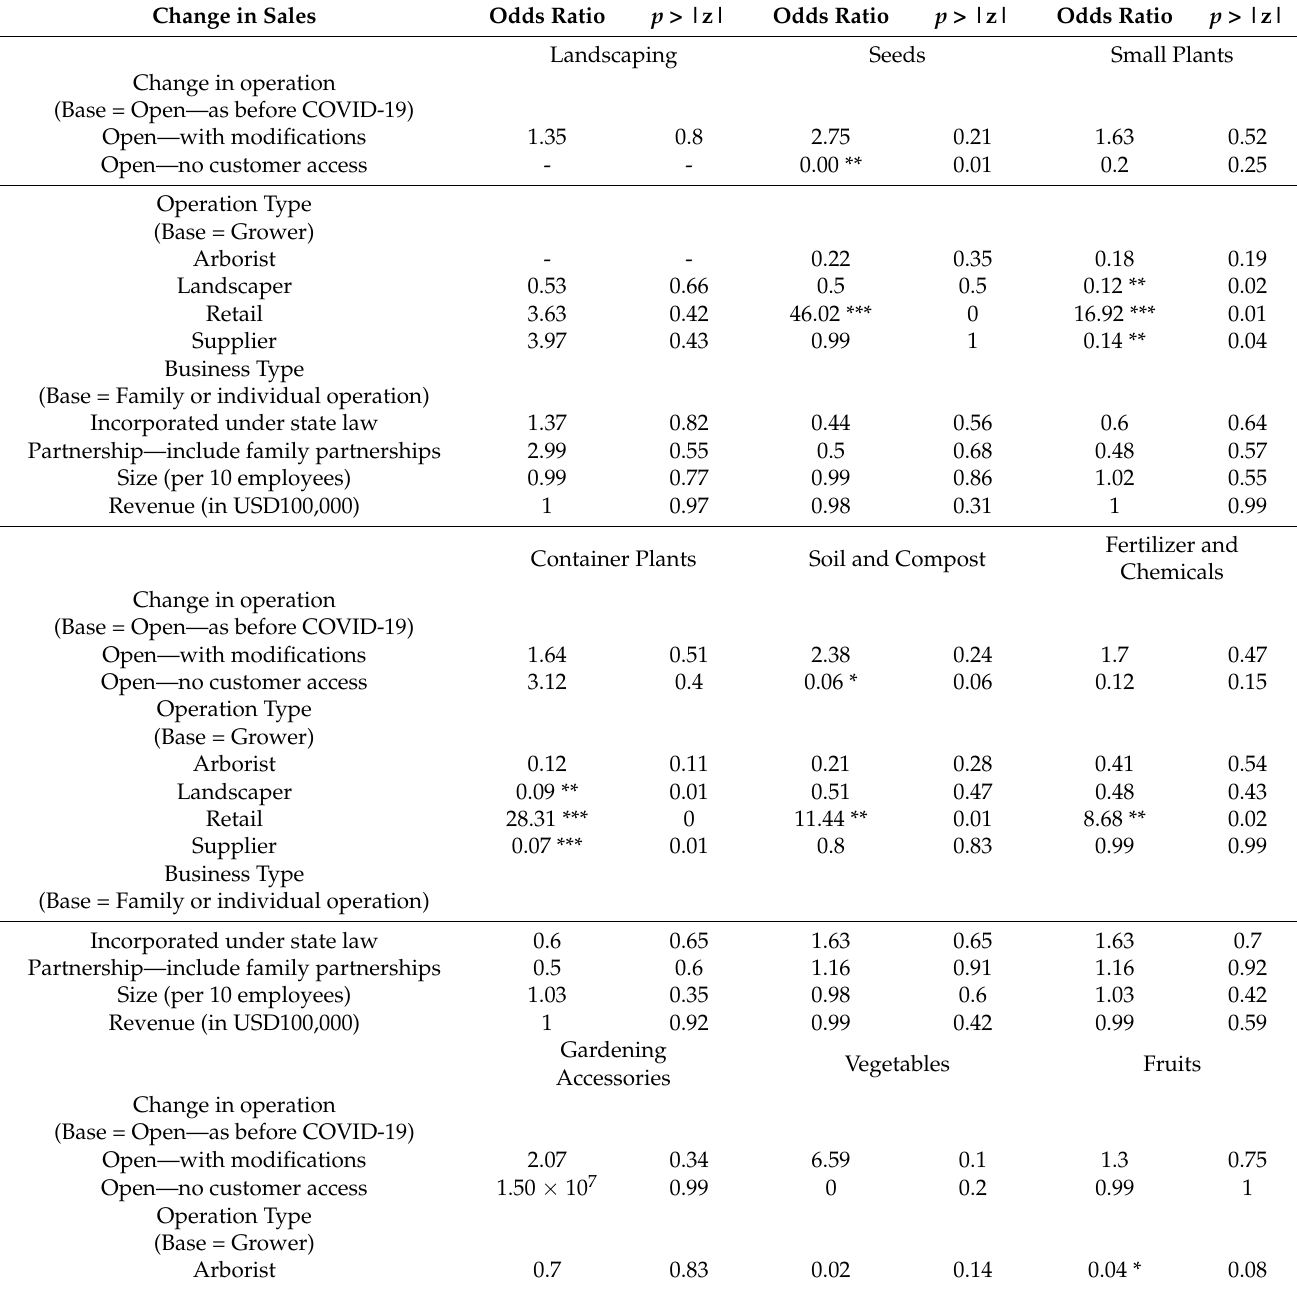
Table 3. Ordered logit model estimates for change in sales of plants and gardening